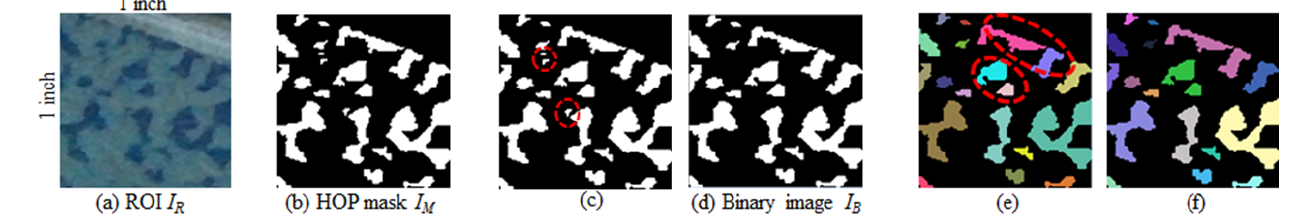
Figure 11. ( a ) Extract ROI I R from the image I ( b ) HOP segmentation using Cascaded U-Net model. ( c ) The area smaller than T area (0.8 mm 2 ) has been removed using C.C labeling. ( d ) After removing the noise. Then marked as the same area with the same color. ( e ) Before K-D tree. ( f ) Grouping after the K-D tree.